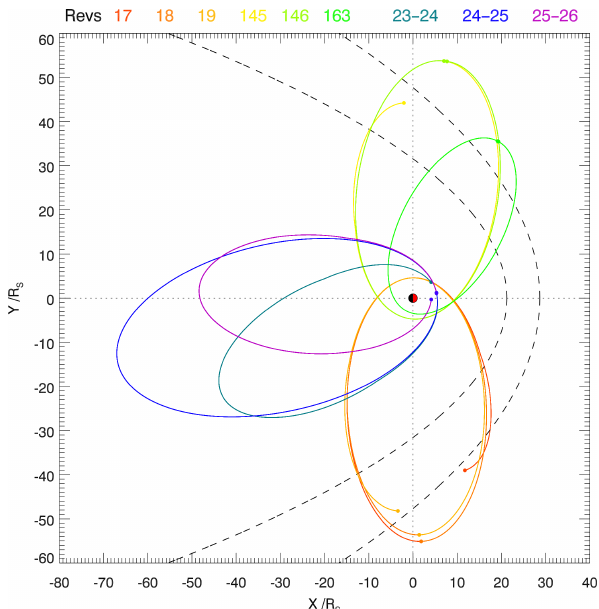
Figure 1. Plot of Cassini orbits whose data are employed in this study, colour-coded as shown at the top of the figure, corresponding to the inbound and outbound passes of Revs 17–19, 145, 146, and 163, together with the apoapsis passes from the outbound pass of Rev 23 to the inbound pass of Rev 26. These orbits are all near- equatorial and are shown looking down on Saturn’s x – y equatorial plane from the north, where the associated z axis is aligned with the planet’s spin (and magnetic) axis, the x – z plane contains the Sun, and y points towards dusk (KSMAG coordinates). The dashed lines show the magnetopause and bow shock for a typical solar wind dynamic pressure of ∼ 0.03nPa, according to the models of Kanani et al. (2010) and Masters et al. (2008),